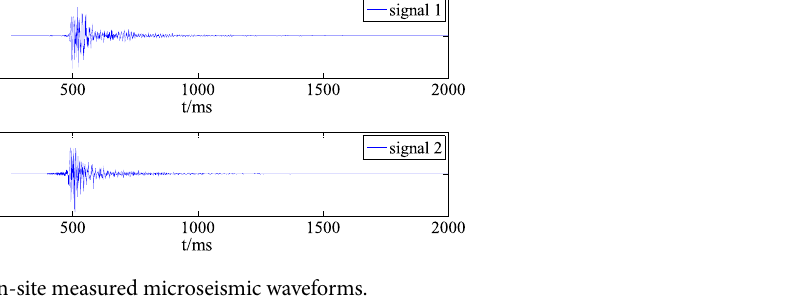
Figure 4. On-site measured microseismic